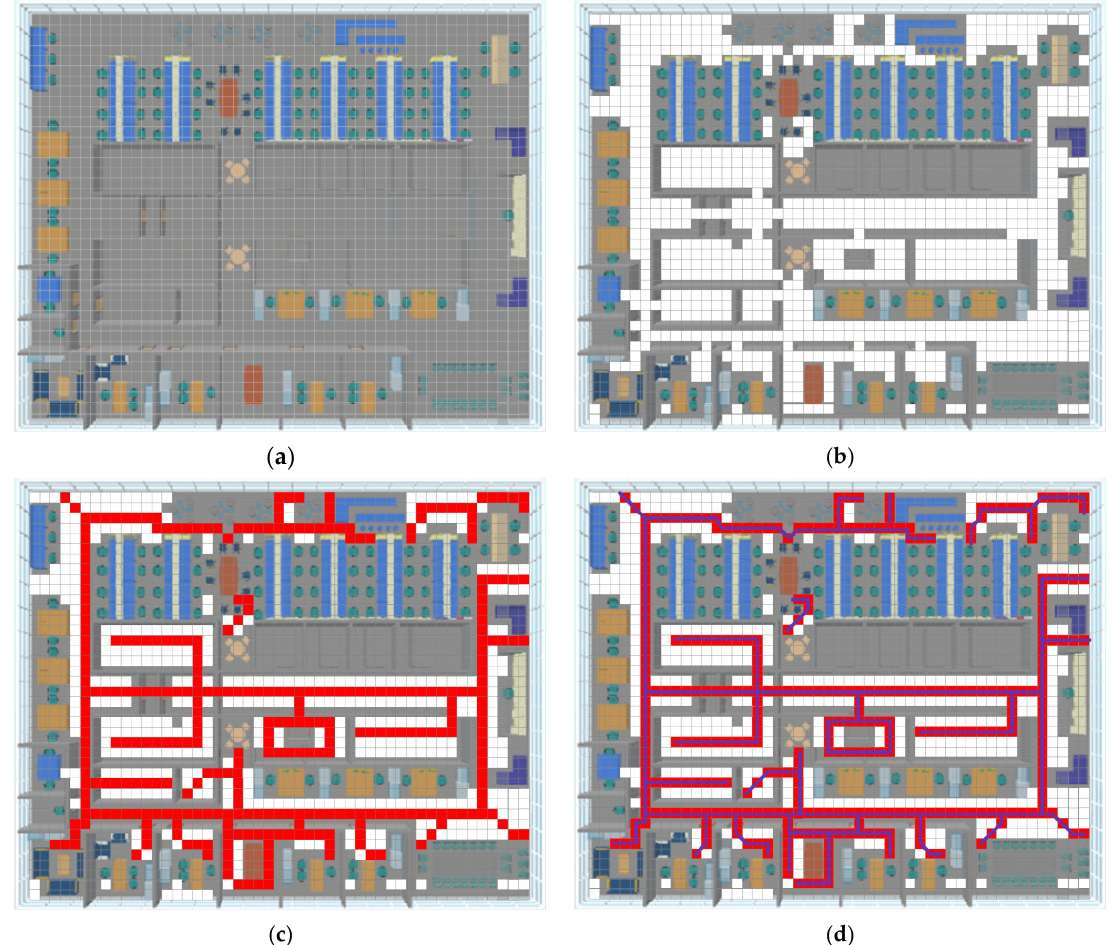
Figure 2. The generation of Grid-Topological map in an office building: ( a ) information extraction, ( b ) discretization and mapping, ( c ) Grid-based map thinning, and ( d ) Grid-Topological map generation.